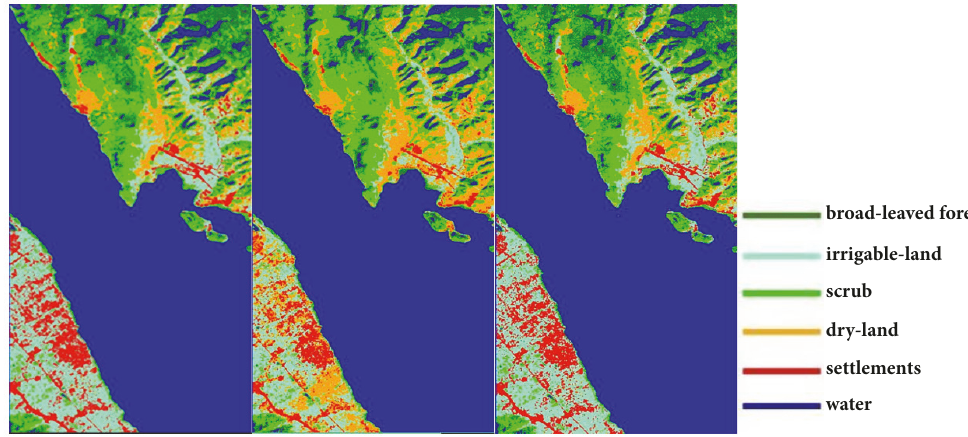
Figure 22: The classification results CART algorithm for the Hyperion